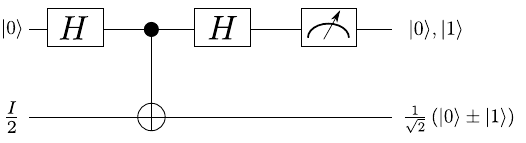
Figure 6. Gate sequence for generating coherence in Alice qubit, which leads to amplification. Without the postselection, Alice will remain in the mixed state and as a result, no amplification of any observable is